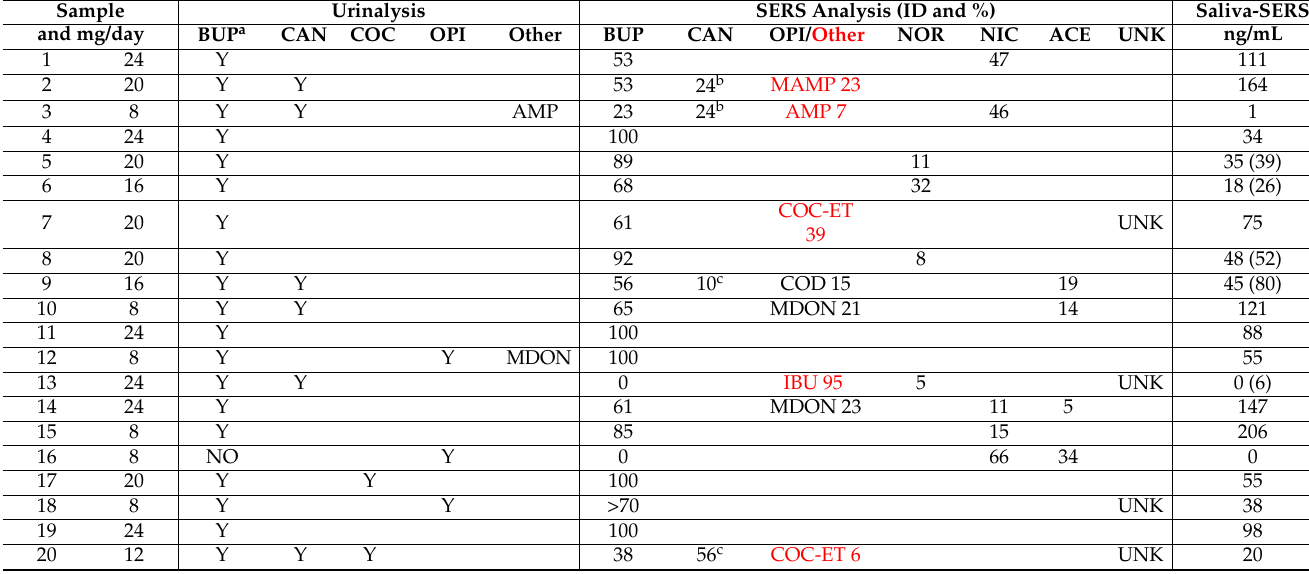
Table 1. Sample number, daily dose, urinalysis, SERS analysis (drugs identification and percentages), and SERS quantitation of buprenorphine in saliva samples.